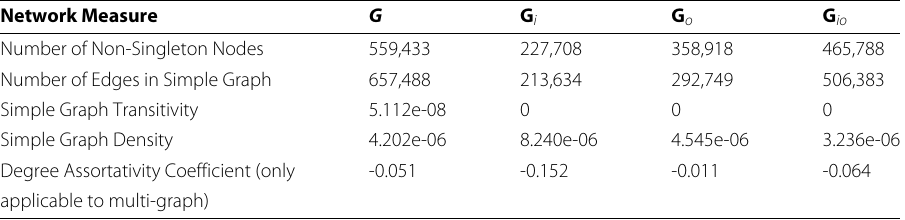
Table 4 Network measures computed for G (reproduced as a baseline from Fig. 2), G i , G o , G io Network Measure G G i G o G io Number of Non-Singleton Nodes 559,433 227,708 358,918 465,788 Number of Edges in Simple Graph 657,488 213,634 292,749 506,383 Simple Graph Transitivity 5.112e-08 0 0 0 Simple Graph Density 4.202e-06 8.240e-06 4.545e-06 3.236e-06 Degree Assortativity Coefficient (only -0.051 -0.152 -0.011